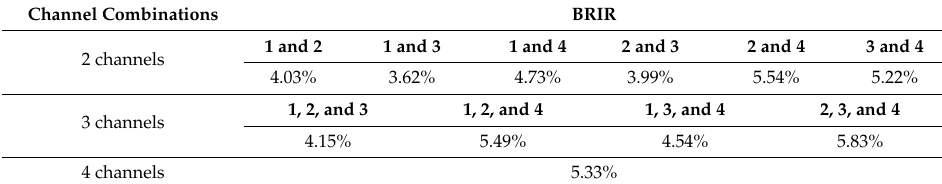
Table 4. BRIR for data fusion results with different channel combination of the multistatic UWB radar. The data was measured when the volunteer was (6 m, − 20 ◦ ) away from the radar. Channel